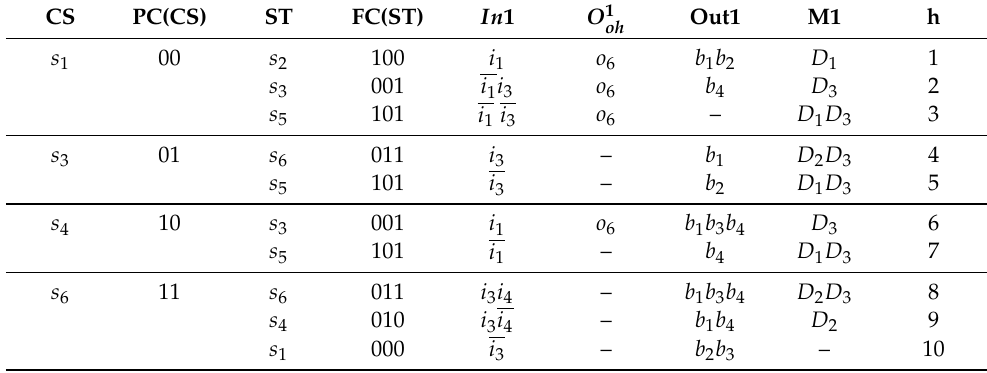
Table 5. Table of block